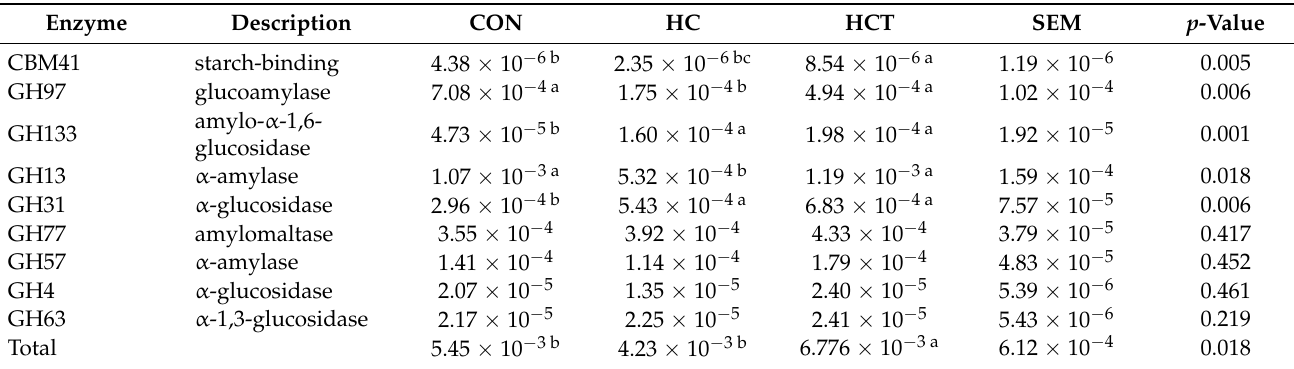
Table 3. Effects of high-concentrate diet and thiamine supplementation treatment on the relative abundance of genes that encoded starch-degrading